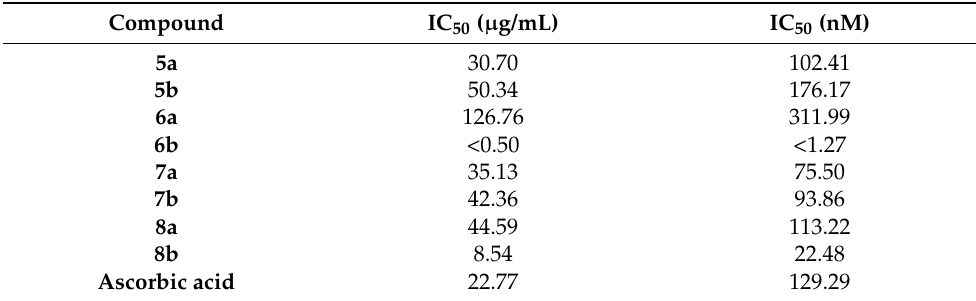
Table 11. The IC 50 values of the compounds against HaCaT cells determined through the MTT method.